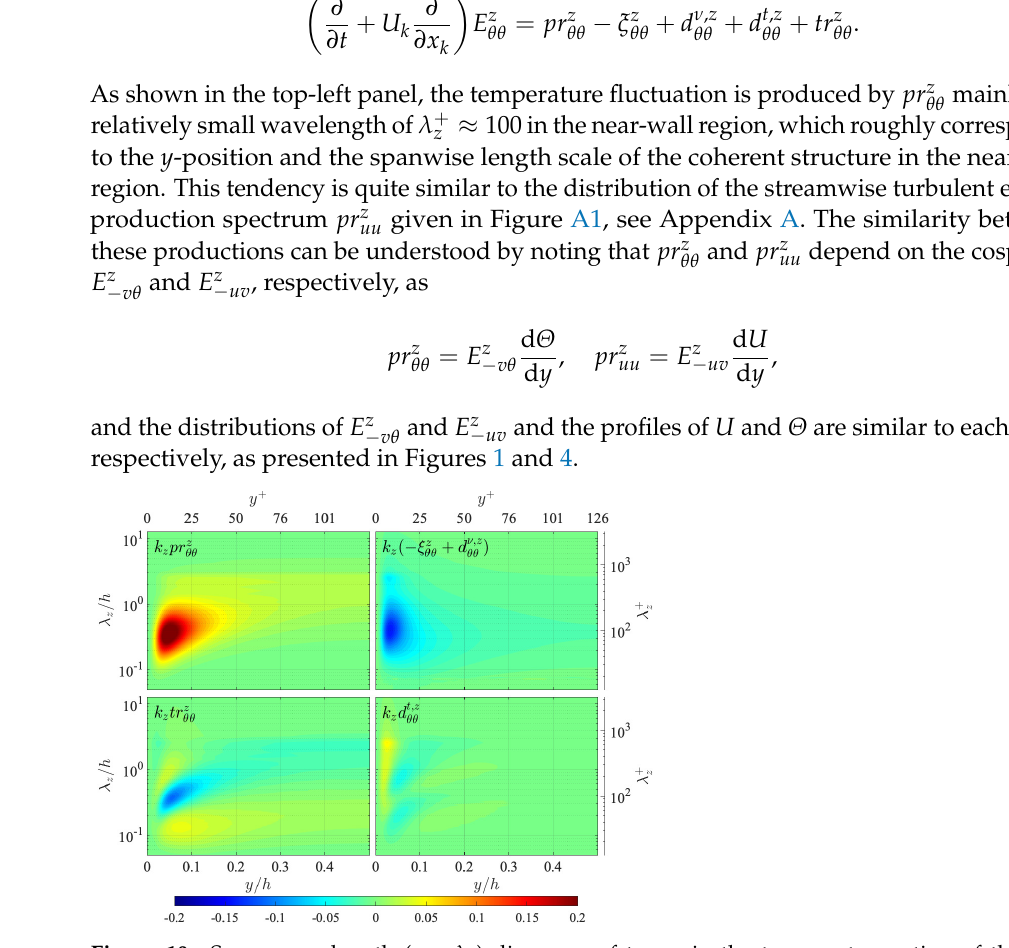
+ d ν , z ; ( top right ) viscous terms ξ z ; θθ θθ θθ . The terms are presented θθ